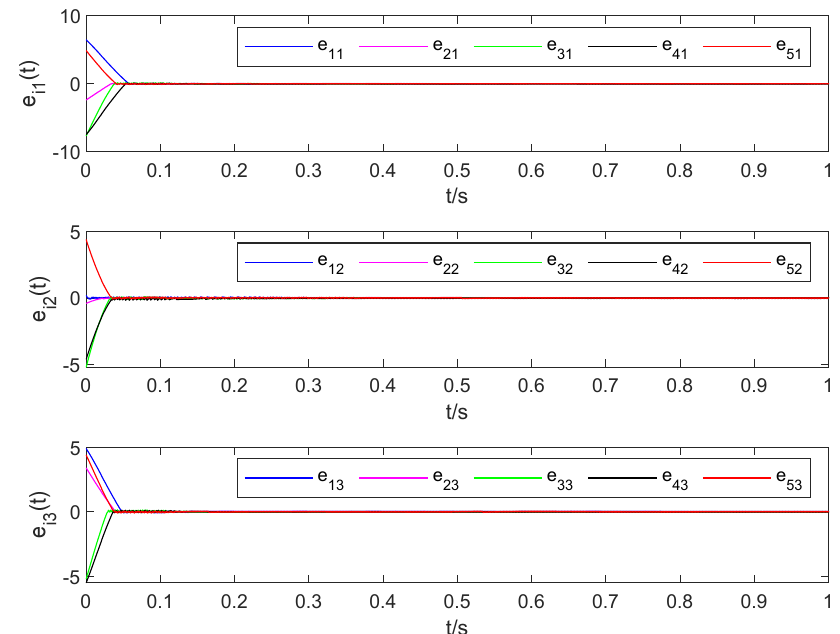
Figure 2. Time evolution of errors, e ij